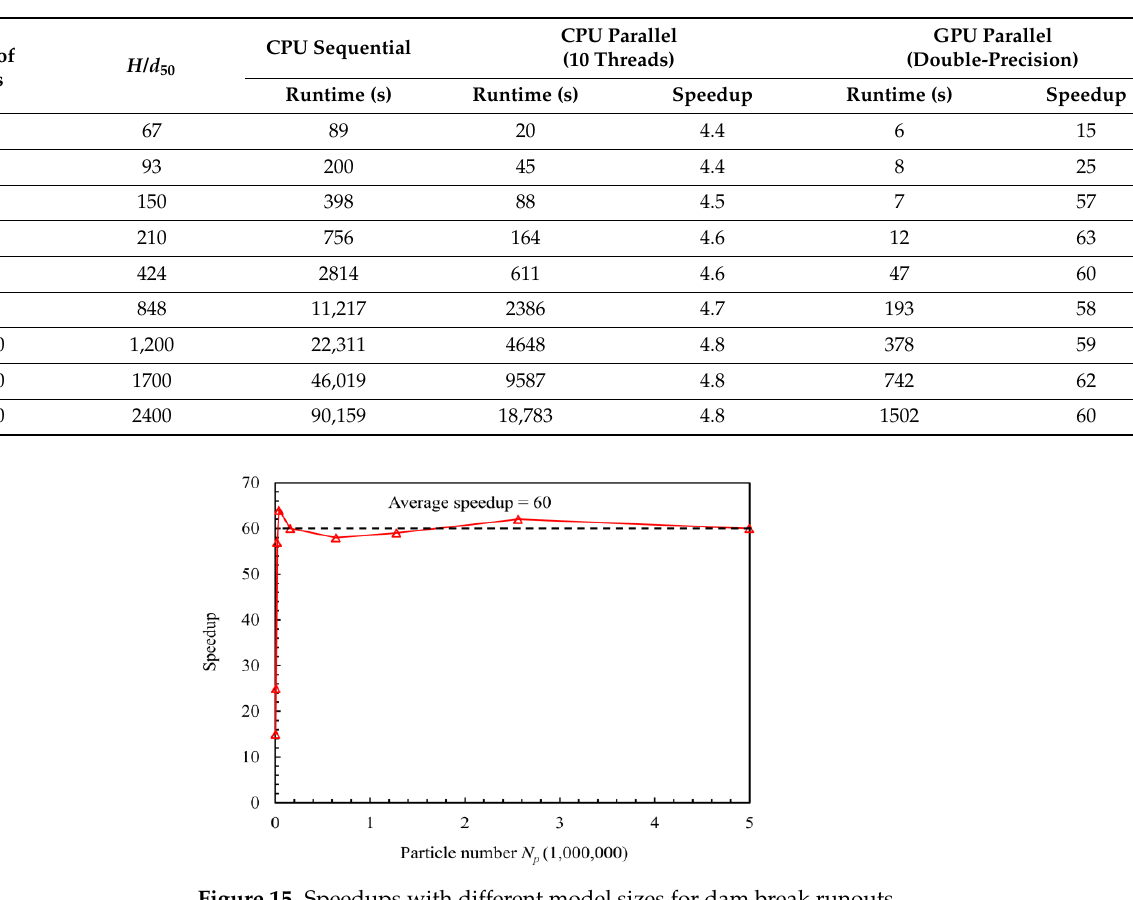
Table 4. Speedups of CPU and GPU parallel simulations in dam break cases (10,000 incremental steps).